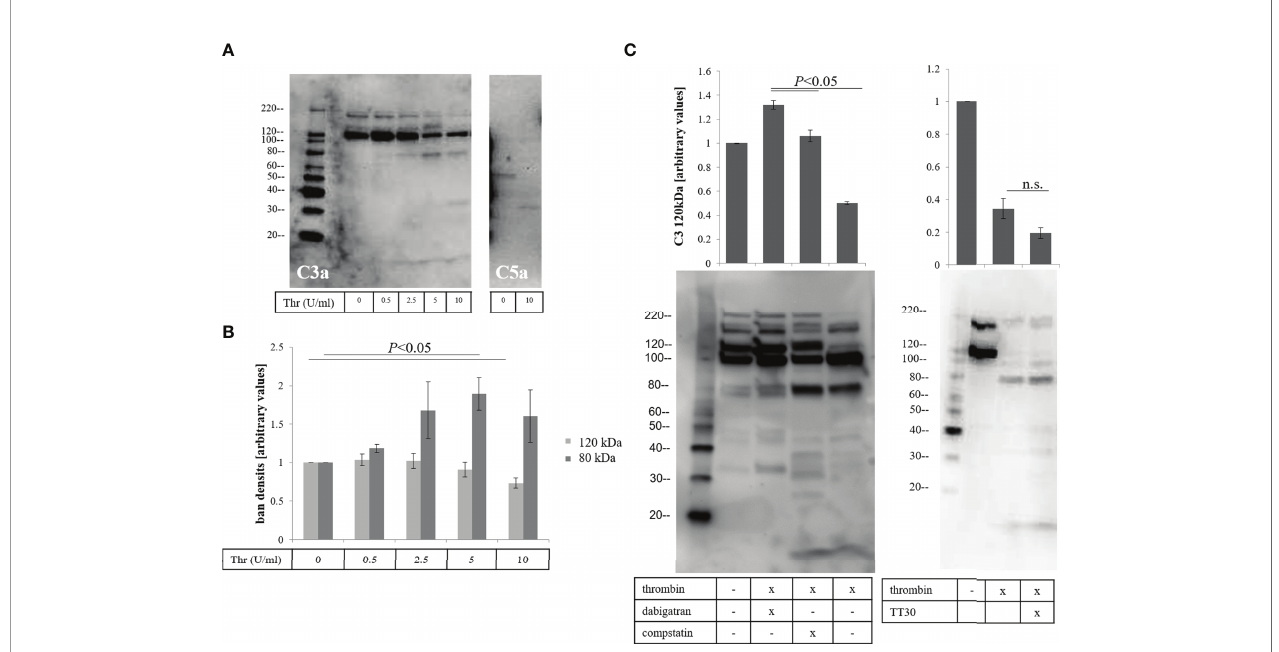
FIGURE 5 | Thrombin-mediated effects on fl uid phase-dependent complement activation. (A) Apical supernatants of treated cells were analyzed for thrombin- mediated complement component C3 (left blot) and C5 (right-hand blot) cleavage, using antibodies against C3a and C5a respectively. (B) Reduction of the 120 kDa and generation of an 80 kDa fragment of C3 are assessed by densitometric analysis using image J. (C) Reduction of the 120 kDa band could be inhibited by dabigatran (10 m M) and the fl uid phase complement inhibitor compstatin (100 m M) (left hand blot) but not the inhibitor of the alternative pathway TT30 (10 m M) that requires membrane binding (right hand blot). Data are plotted as mean ± SEM; n = 3 independent experiments.